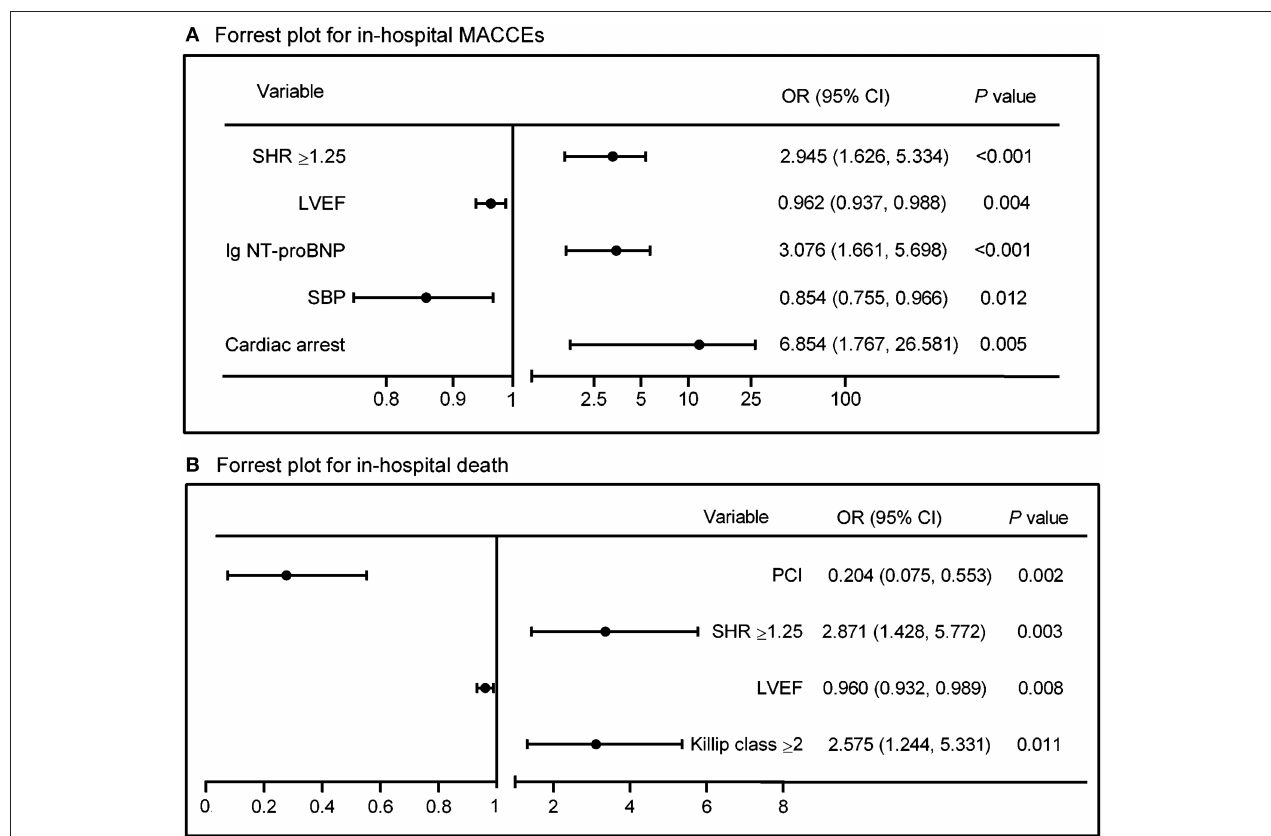
FIGURE 3 | Forest plots showing risk factors for in-hospital (A) MACCEs and (B) mortality by multivariate logistic analysis. Summary estimates in (A) for SBP indicate OR per 10 mmHg increment in SBP. SHR, stress hyperglycemia ratio; LVEF, left ventricular ejection fraction; NT-proBNP, N-terminal pro-B type natriuretic peptide; SBP, systolic blood pressure; PCI, percutaneous coronary intervention; OR, odds ratio; CI, confidence incidence.